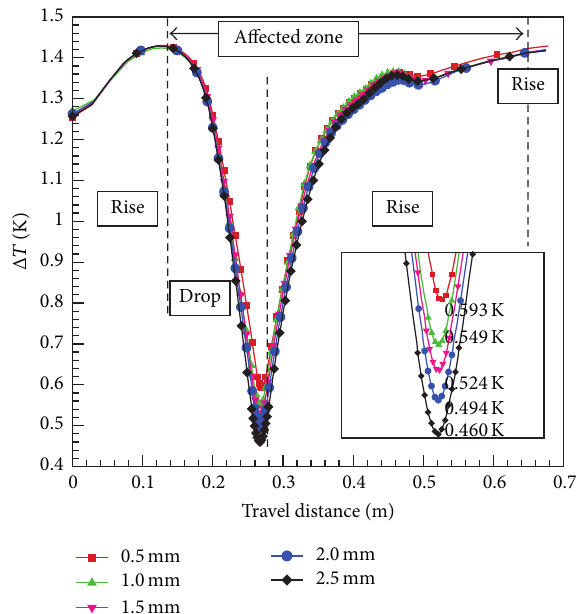
Figure 7: Effect of erosion reduced thickness on temperature drop along the extrados of pipe.